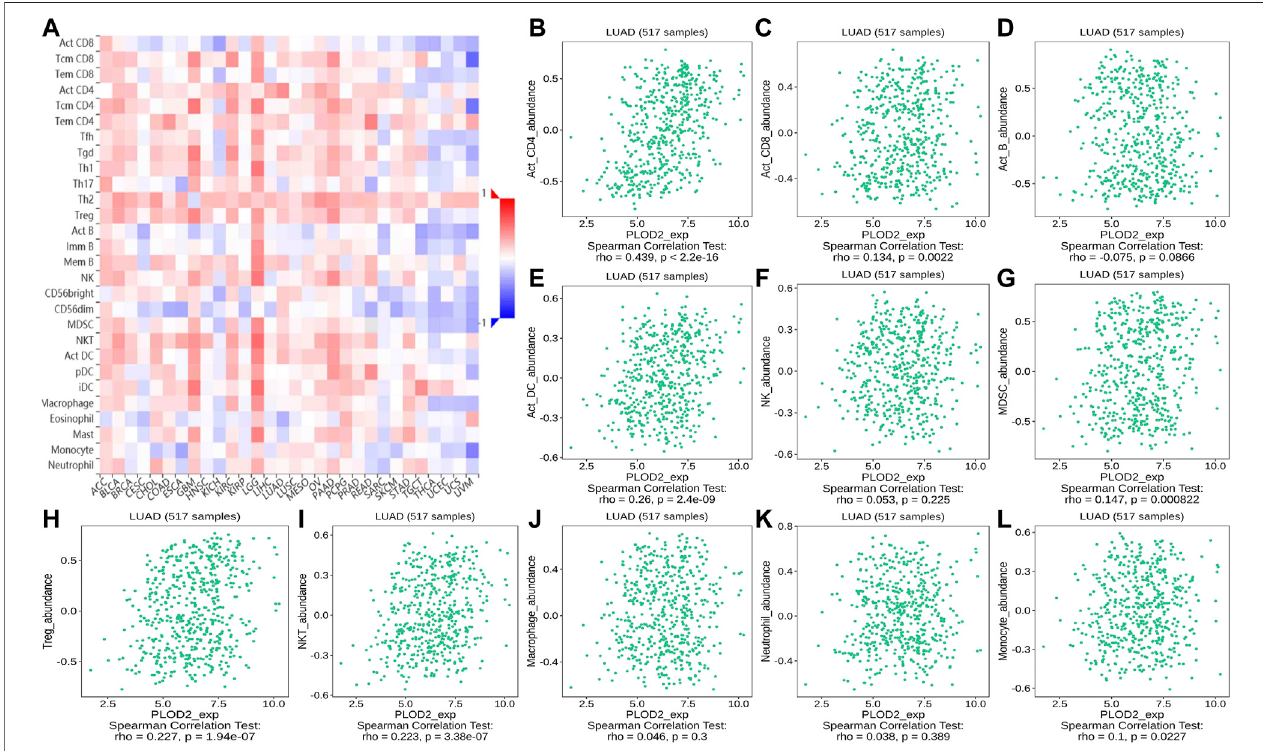
FIGURE 13 | Correlation of PLOD2 expression with TILs. (A) Heatmap of PLOD2 expression in pan-cancer from the TISIDB database. (B – L) PLOD2 expression level is signi fi cantly correlated with in fi ltrating levels of activated CD8 + T cells, activated CD4 + T cells, activated DCs, activated CD8 + T cells, MDSCs, Treg cells, and NKT